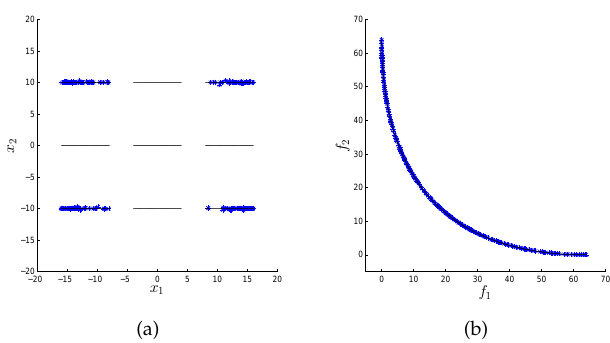
Figure 7. Graphical results of the run with the median values for the RPH1 function for the NSGA-II algorithm. ( a ) Decision Space Original; ( b ) Objective Space Original; ( c ) Decision Space VR; ( d ) Objective Space VR.